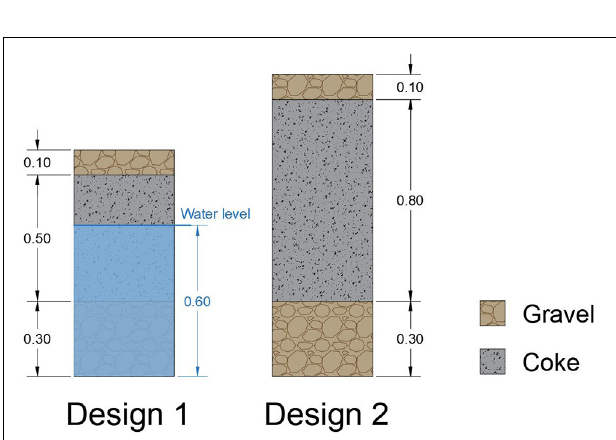
FIGURE 2 | Construction profiles of METland R (cid:13) designs validated in this work.